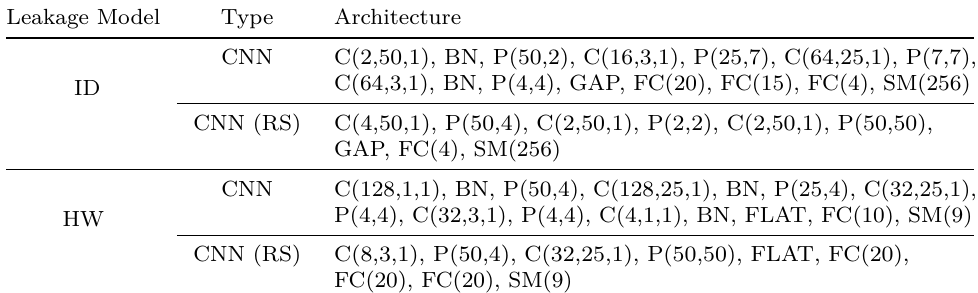
Table 11: The best found architectures for the ASCAD fixed key dataset with desynchro- nization of